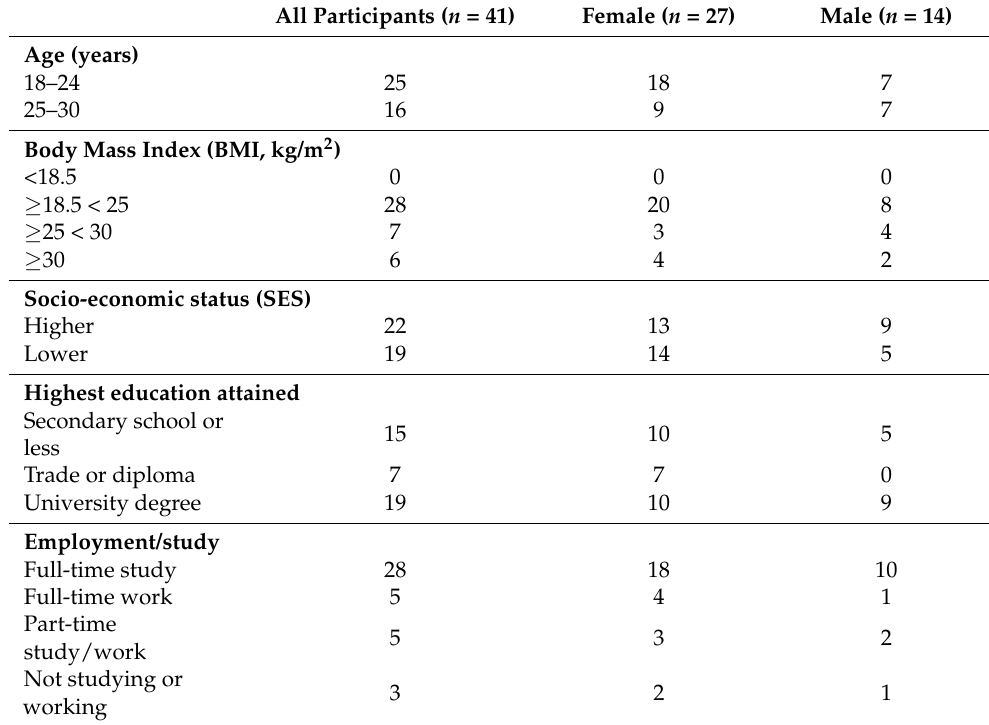
Table 2. Participant characteristics and differences between male and female participants.